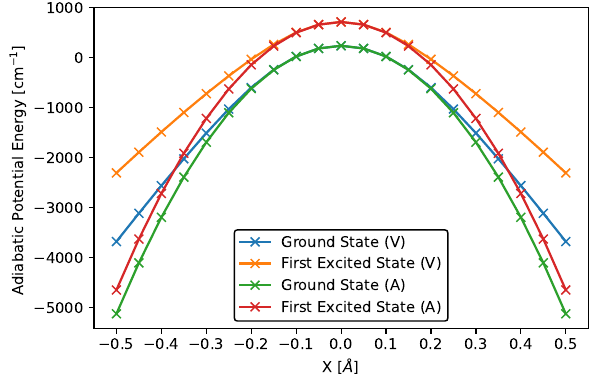
Figure 3. Ground- and first-excited state adiabatic potential energy surfaces of the 1D quadratic proton transfer model. V denotes a variational result, and A denotes an analytical result. The following parameter values were used to obtain these surfaces: A 0 = 3367.6 cm − 1 Å − 2 , k 1 = 1.7 × 10 4 cm − 1 Å − 2 , and m = 1